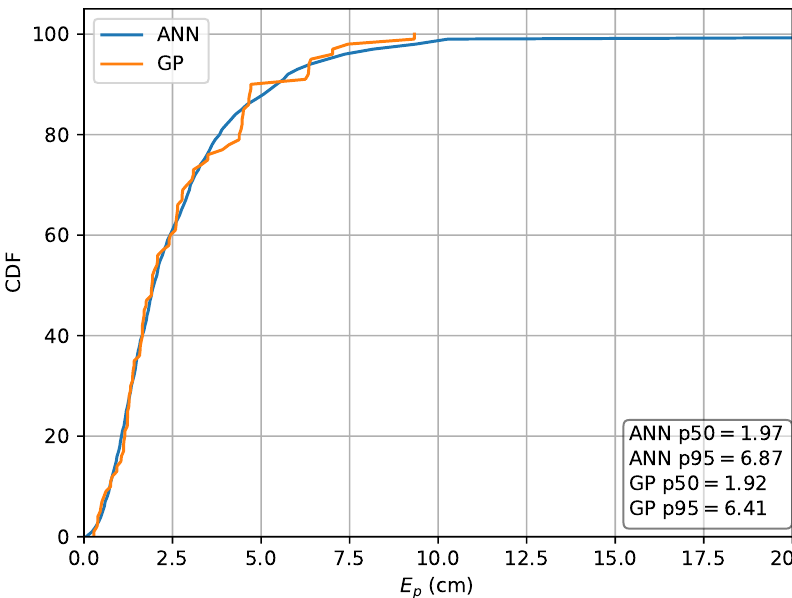
Figure 10. Cumulative distribution of the error evaluated on set A for the Machine Learning (ML) methods in the case the absolute intensities r are used as